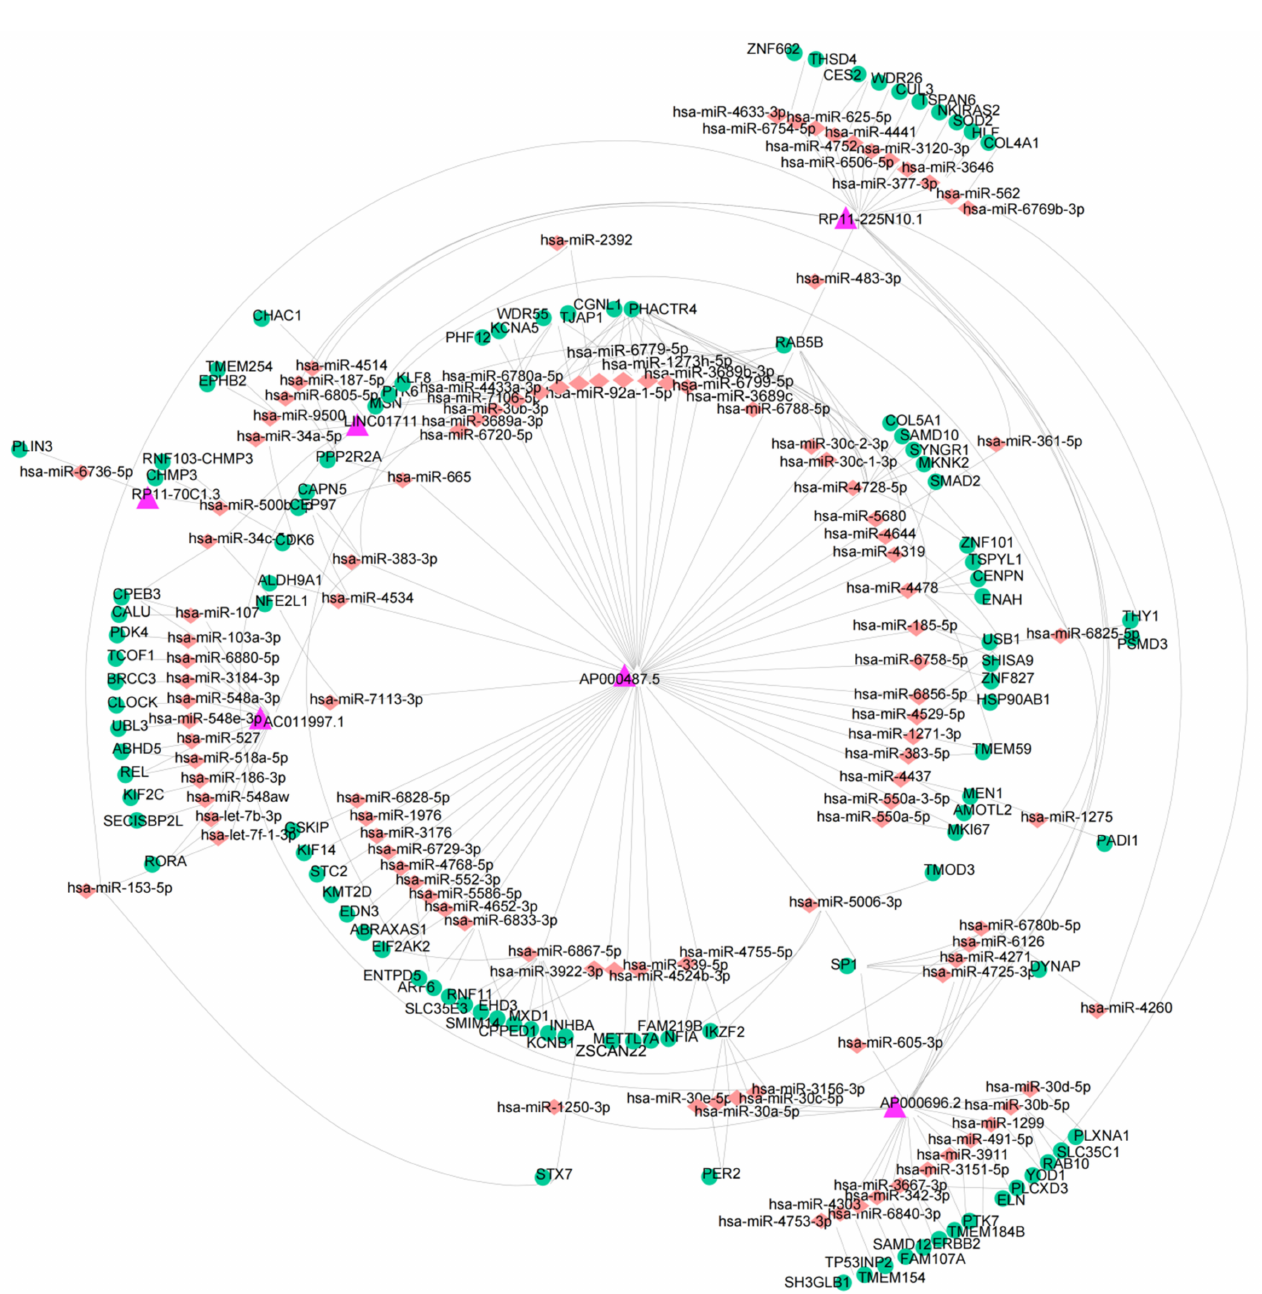
Figure 7. The ceRNA network was constructed of the six prognosis-related DEARlncRNAs (purple) and their target miRNAs (orangered) and mRNAs